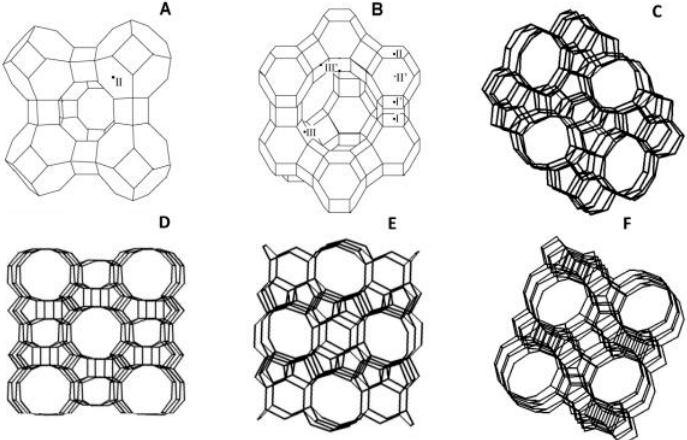
Figure 2. Industrially most important zeolite structures: ( A ) LTA; ( B ) FAU; ( C ) ZSM-5 (Zeolite Socony Mobil-5); ( D ) MOR (Mordenite Framework); ( E ) FER (Ferrierite); and ( F ) BEA (Beta Polymorph). The lines represent the O atoms and the corners Si or Al atoms, and the exchangeable cation sites in LTA and FAU are indicated; Reproduced with permission from [29].